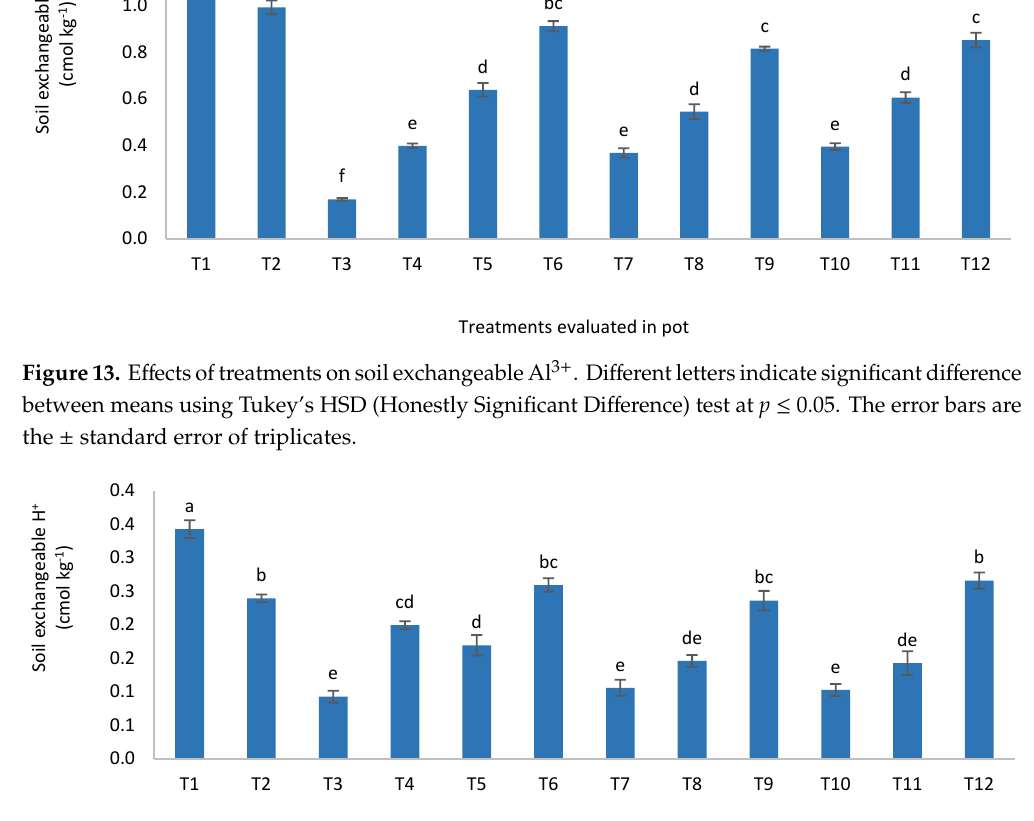
Figure 14. Effects of treatments on soil exchangeable H + . Different letters indicate significant difference between means using Tukey’s HSD (Honestly Significant Difference) test at p ≤ 0.05. The error bars are the ± standard error of triplicates.